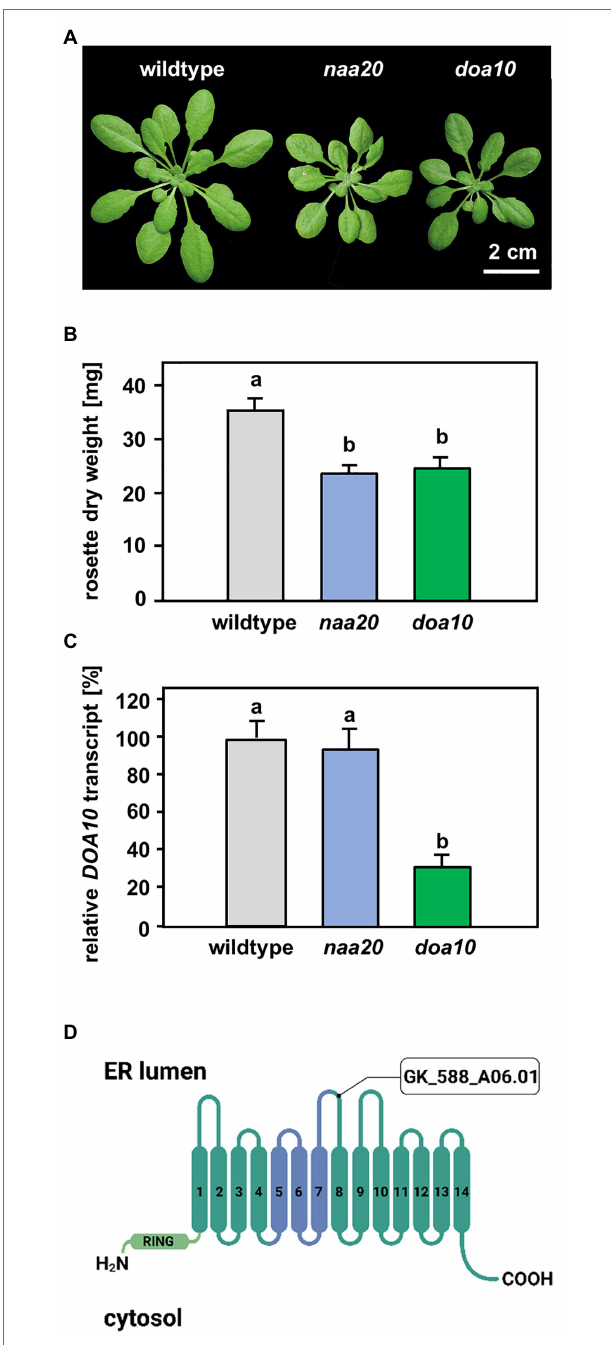
FIGURE 3 | Comparison of naa20 and doa10 under optimal growth conditions. (A) Growth phenotype of representative wildtype, naa20 and doa10 plants after 6 weeks of growth on soil under short-day conditions (scale bar = 2 cm). (B) Rosette dry weight of six-week-old soil-grown wildtype, naa20 and doa10 plants. (C) Relative DOA10 transcript level in ten-day-old seedlings ( n = 3, 1n = 15 seedlings). The forward and reverse primer bound to the seventh and eight exons of the DOA10 transcript, respectively. (D) The tDNA insertion in GK_588_A06.01 disrupts the eighth of 14 transmembrane domains in the DOA10A protein. The conserved 130-residue domain present in all DOA10 orthologs (Swanson et al., 2001) is shown in blue, whereas the RING domain is represented in light